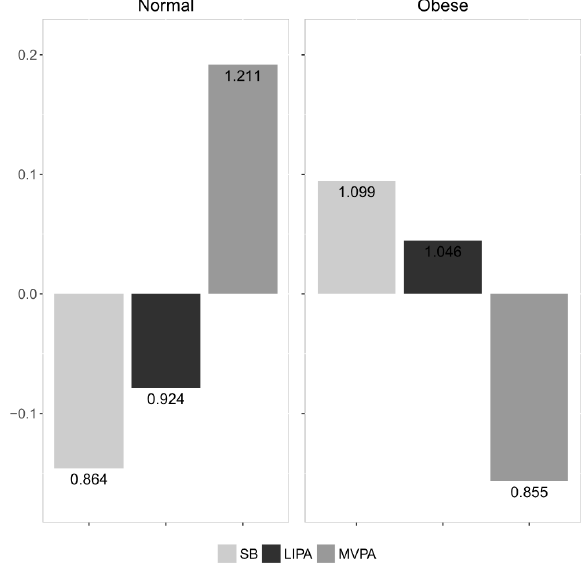
Figure 2. Compositional mean barplots for fat mass percentage (FM%) categories. The values on the left vertical axis correspond to the log-ratios between the subgroup’s centre and the overall centre after centering the data, whereas the numeric labels of the bars display the actual proportion relative to the overall mean composition.